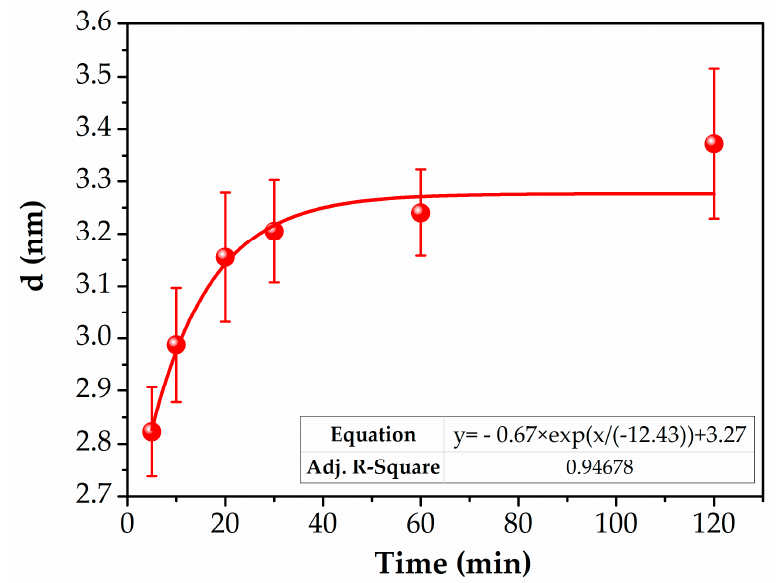
Figure 3. Estimated average size of the CdTe nanocrystals (d) as a function of the annealing time.